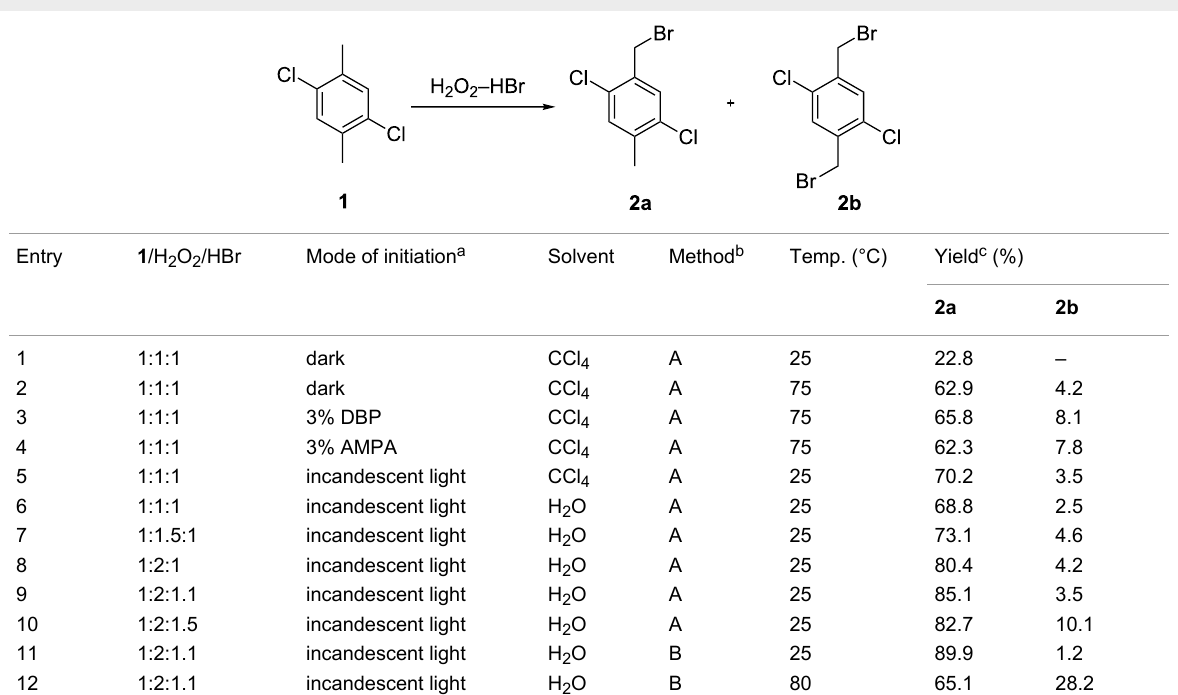
Table 1: Bromination of 2,5-dichloro- p -xylene ( 1 ) with H 2 O 2 –HBr.